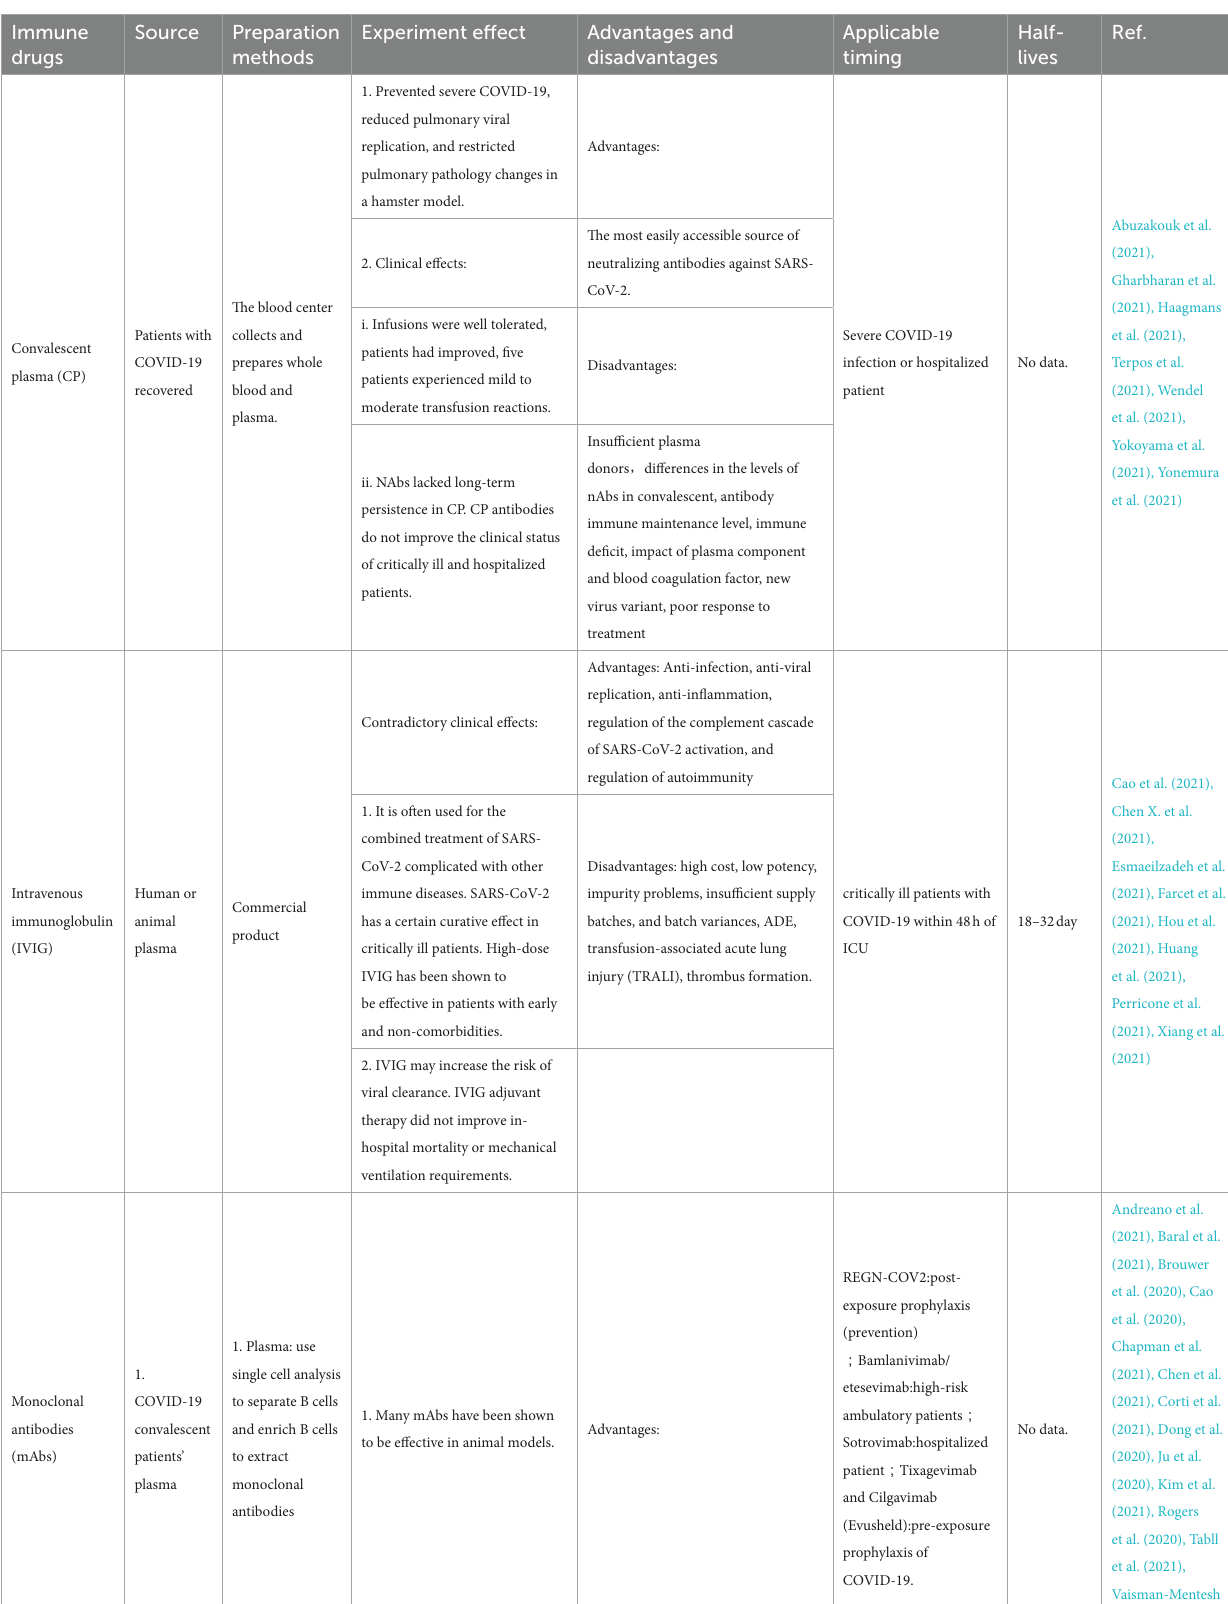
TABLE 1 Comparison of different immune